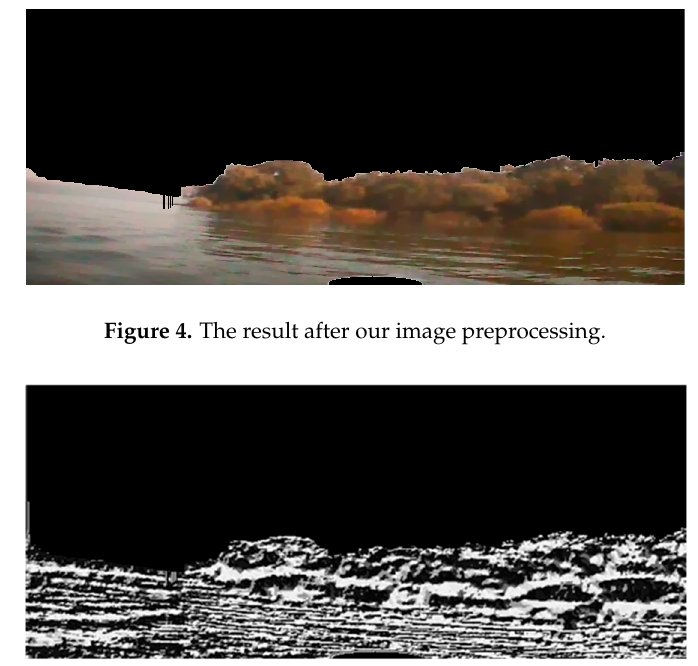
Figure 4. The result after our image preprocessing.